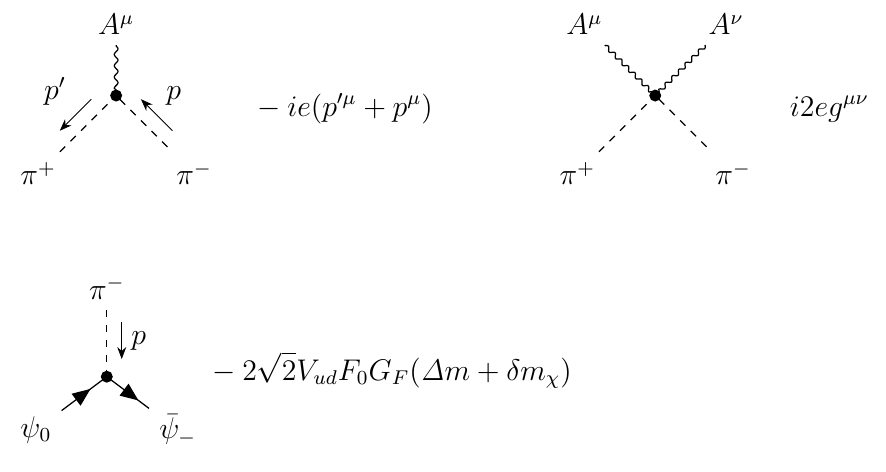
Figure 18 . The Feynman rules of the Wino-pion interactions in eq.